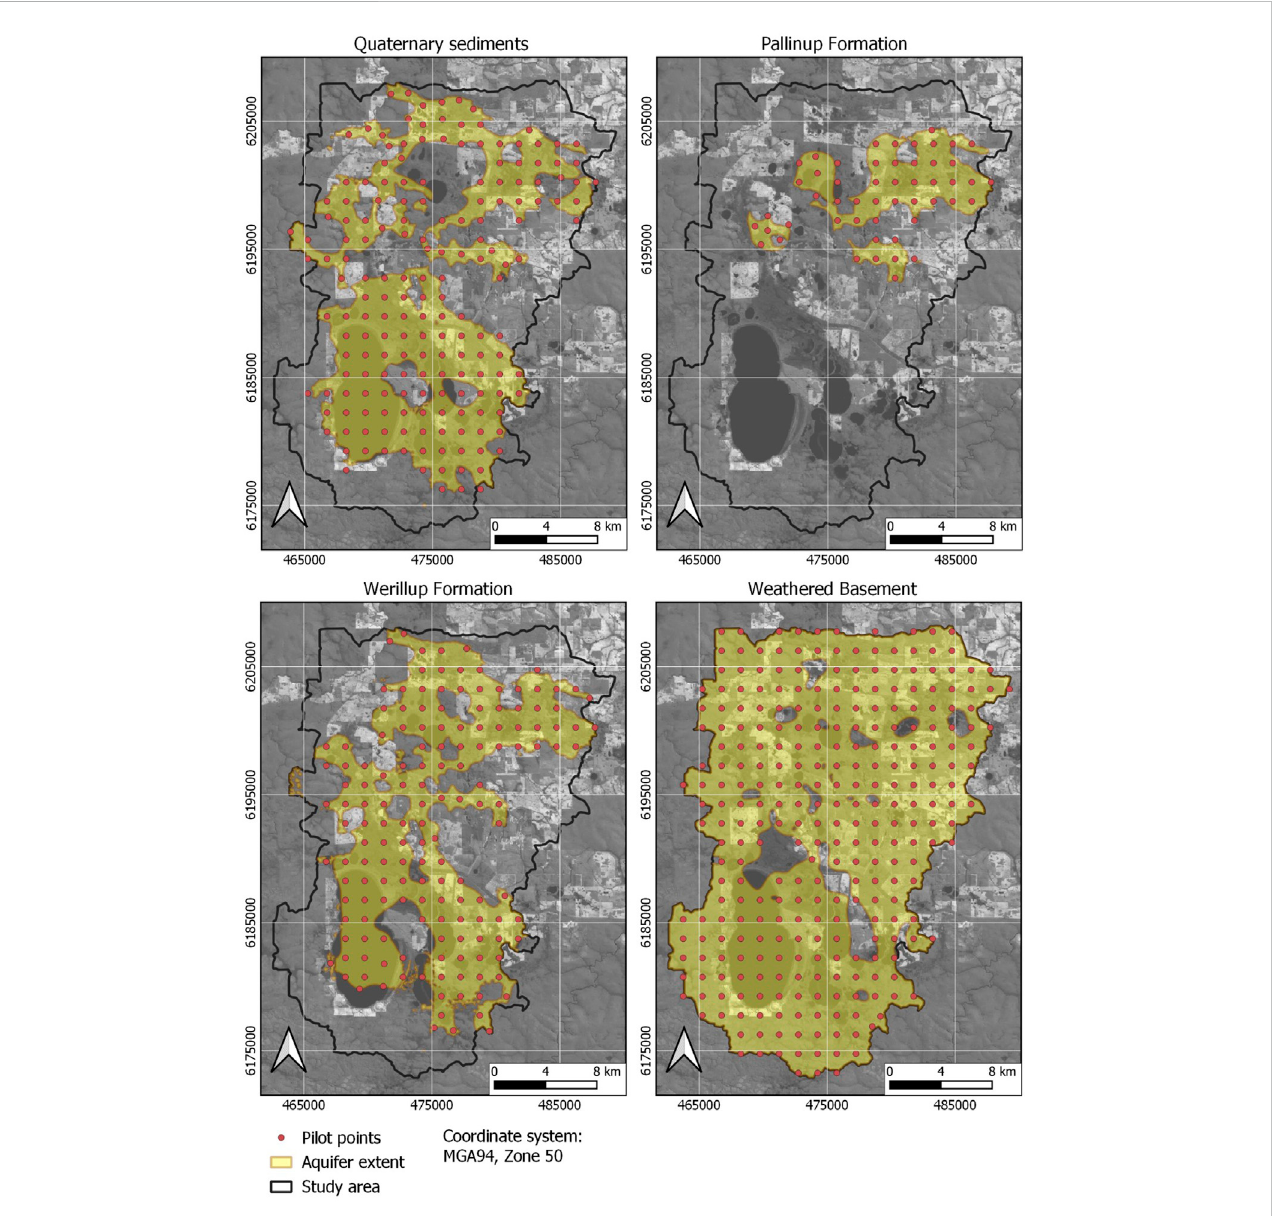
FIGURE 5 Distribution of pilot points for the different hydrogeological